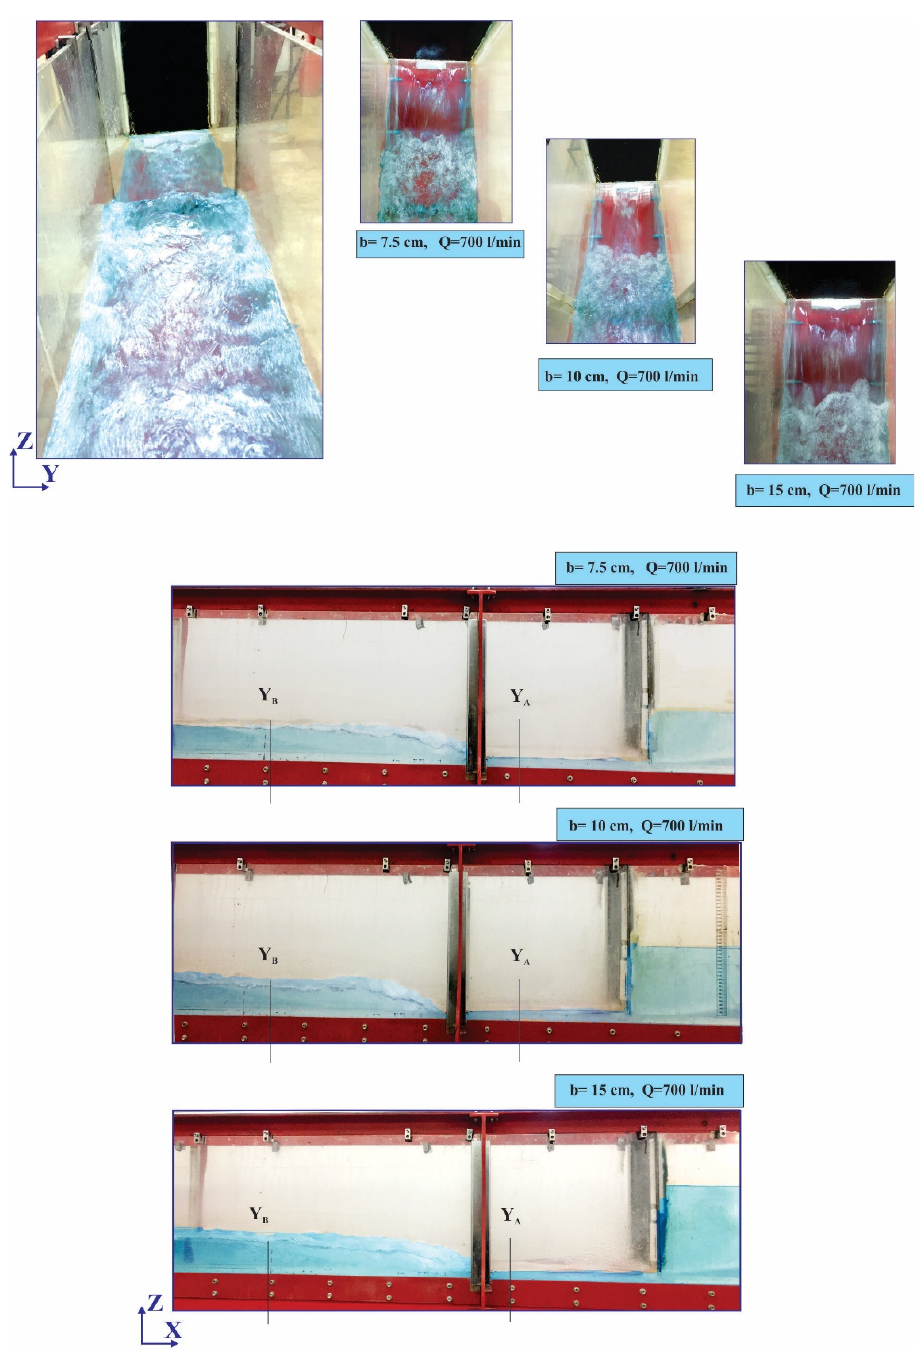
Figure 6. Laboratory images of hydraulic jump formation with rectangular cubic sills of different widths.